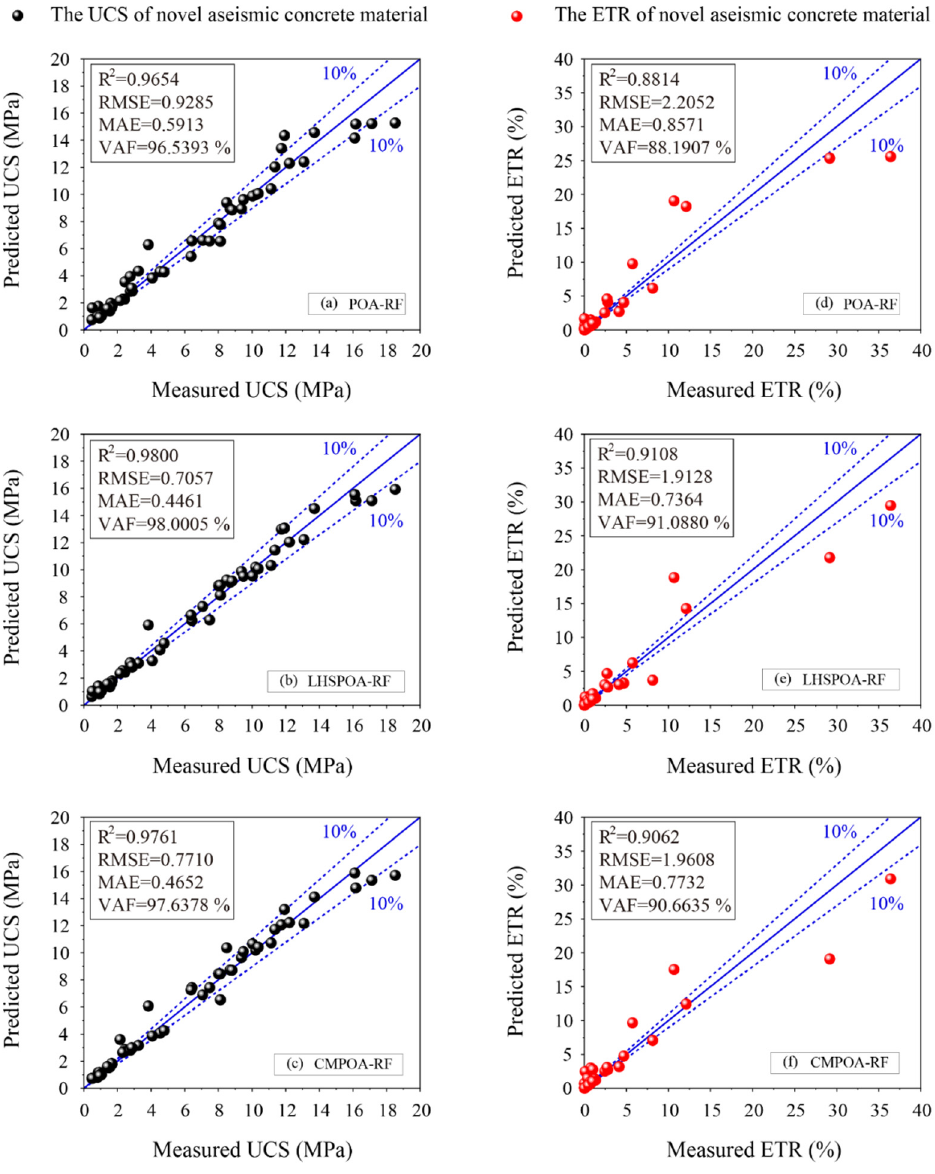
Figure 6. The regression diagrams of the proposed models for predicting the UCS and ETR in the training phase. Table 7. The performance indices of the proposed models in the testing phase.